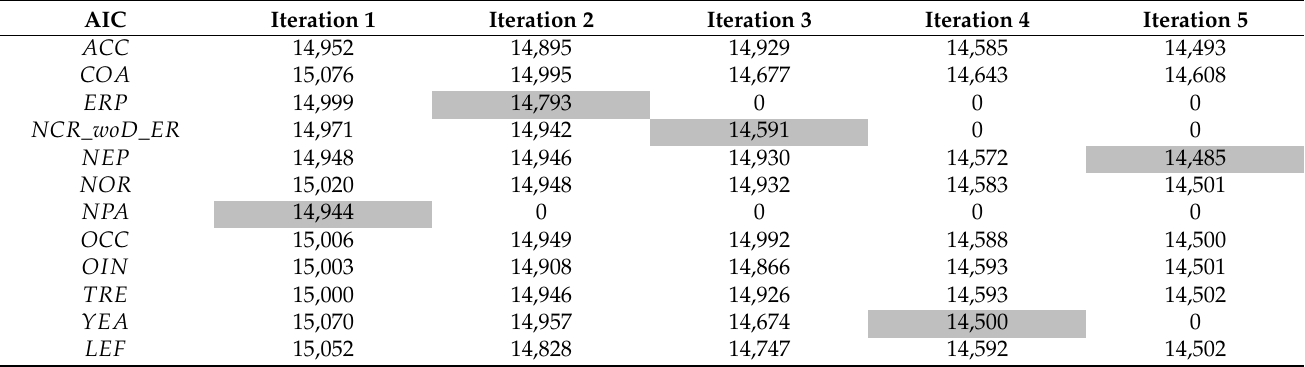
Table A4. AIC values of the explanatory variables for the non-life